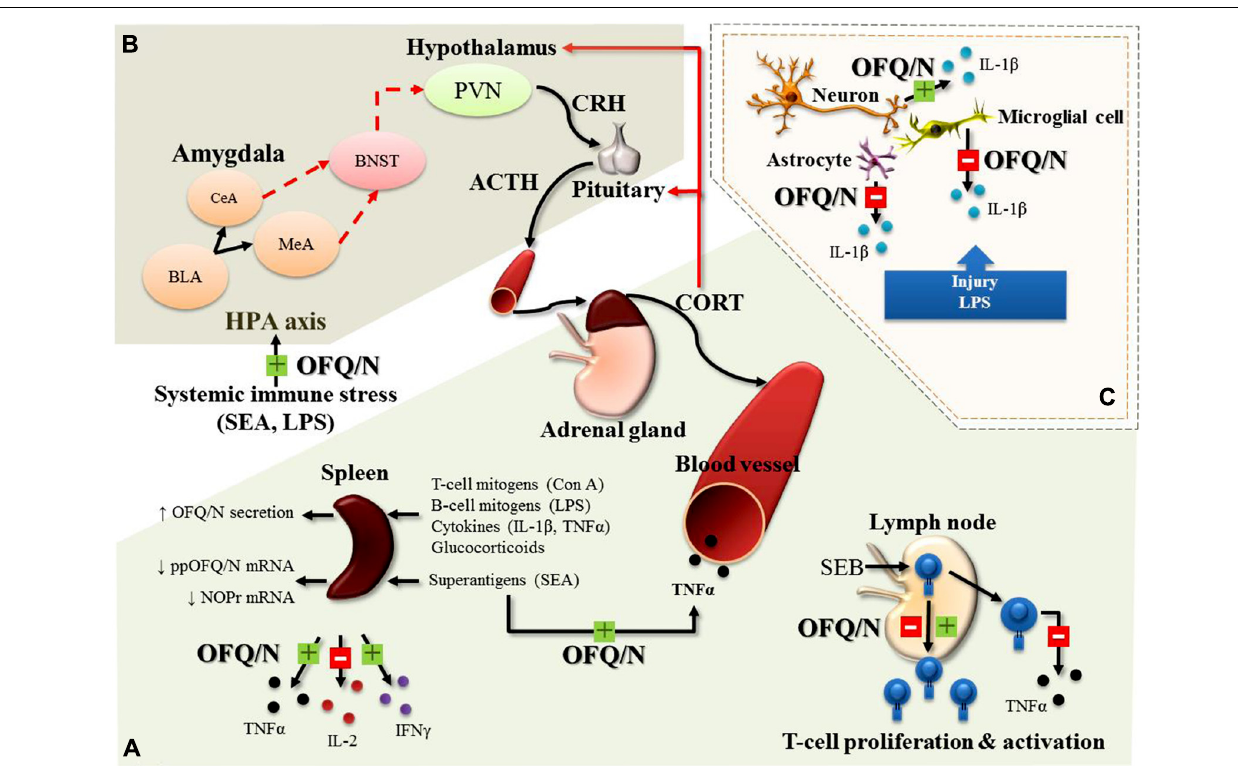
FIGURE 3 | Major, immunomodulatory effects of OFQ/N in the periphery (A), feed-forward effects of OFQ/N on the hypothalamic-pituitary- adrenal (HPA) axis response to systemic immune stress (B) and immunomodulatory effects of OFQ/N in the central nervous system (CNS; C). In general, the hypothesized role of the nociceptin system is believed to be anti-inflammatory, a function that may be exerted through regulation of cytokine expression. In response to a wide variety of immunologic stimuli (Con A, concanavalin A; LPS, lipopolysaccharide; IL-1 β , Interleukin-1 beta;TNF α , tumor necrosis factor alpha; SEA, staphylococcal enterotoxin A) OFQ/N inhibits (red box with minus) or enhances (green box with plus) the release of inflammatory cytokines (TNF α , interleukin-2; IL-2 and interferon gamma; IFN γ ) from splenocytes and lymphocytes and enhances SEA-induced elevations in circulatingTNF α . Nociceptin also modulates T-lymphocyte proliferation and activation following superantigenic challenge